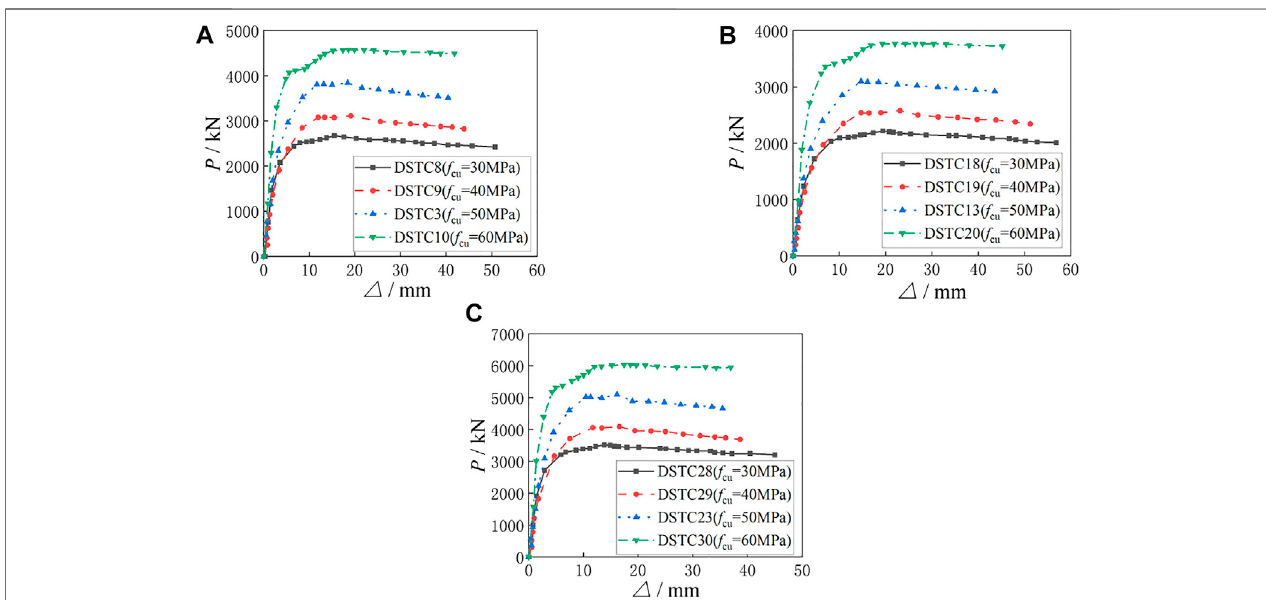
FIGURE 11| Comparisonsof load-displacement curves ofspecimens with different concretestrengths. (A) Load-displacement curves ofgroup Aspecimens. (B) Load-displacement curves of group B specimens. (C) Load-displacement curves of group C specimens.